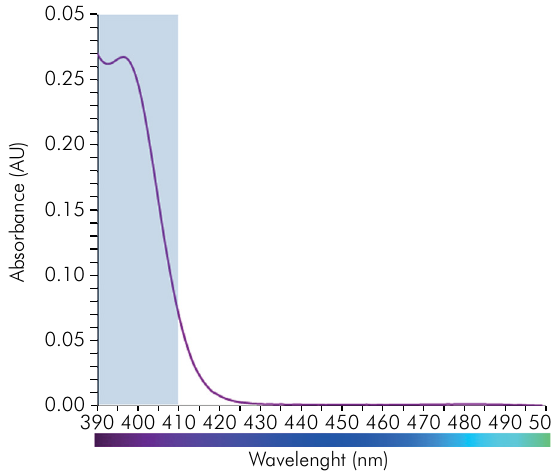
Figure 8. Visible light absorption spectrum of camphorquinone, ranging from about 425 to 495 nm.